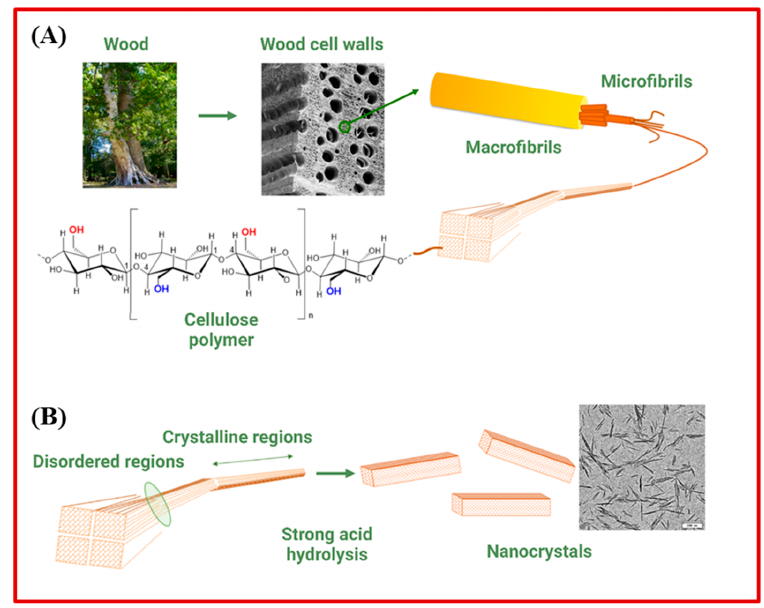
Figure 2. ( A ) The hierarchical structure of cellulose nanofibers derived from the tree. ( B ) The fabrication of cellulose nanocrystals (CNCs) from the nanofibrous network using acid. Adapted with permission from Ref. [57], Copyright 2015, Intech.